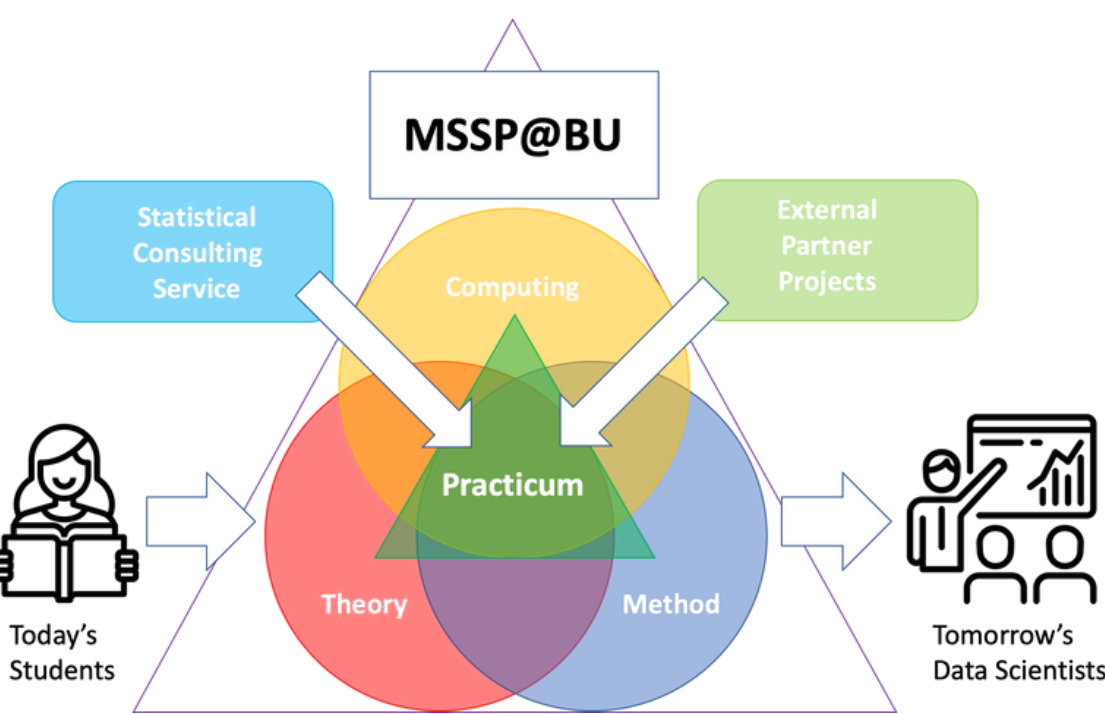
Figure 1 . A visual representation of the central role played by the Statistics Practicum in the Boston University M.S. in Statistical Practice program. More traditional courses in computing, methods, and theory are linked to each other through the practicum, which is the central organizing element —and, indeed, the heart—of the program. The multiple and substantive real-world practical experiences obtained by each student during the two- semester practicum is fed by the two complementary sources of a university statistical consulting service and a constellation of external partner projects (e.g., industry, government, and nonprofits). Note. Figure icons from